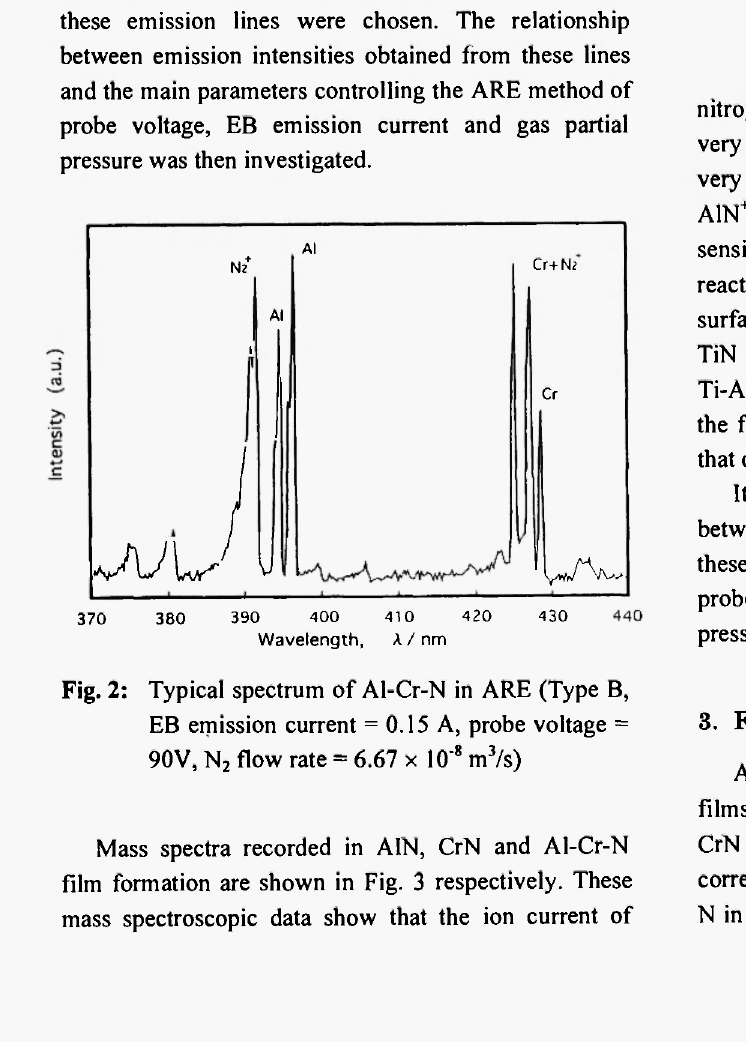
Fig. 2: Typical spectrum of Al-Cr-N in ARE (Type B, EB emission current = 0.15 A, probe voltage = 90V, N 2 flow rate = 6.67 χ 10" 8 m 3 /s)